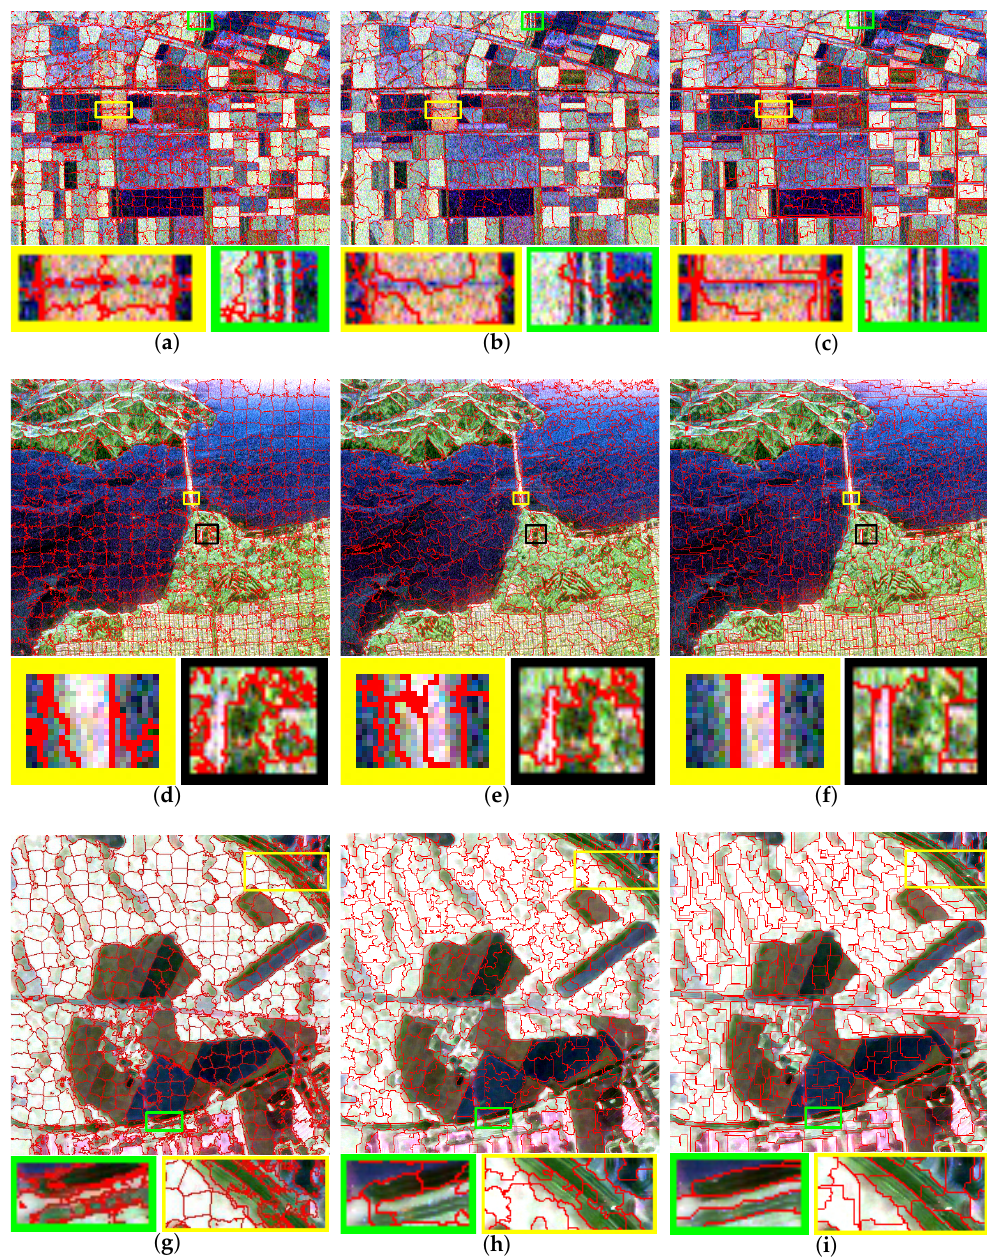
Figure 10. The visual superpixel generation maps. ( a ) The superpixel generation map and partial enlarged details obtained by SLIC on Flevoland data set. ( b ) The superpixel generation map and partial enlarged details obtained by SEEDs on Flevoland data set. ( c ) The superpixel generation map and partial enlarged details obtained by PAN on Flevoland data set. ( d ) The superpixel generation map and partial enlarged details obtained by SLIC on San Francisco data set. ( e ) The superpixel generation map and partial enlarged details obtained by SEEDs on San Francisco data set. ( f ) The superpixel generation map and partial enlarged details obtained by PAN on San Francisco data